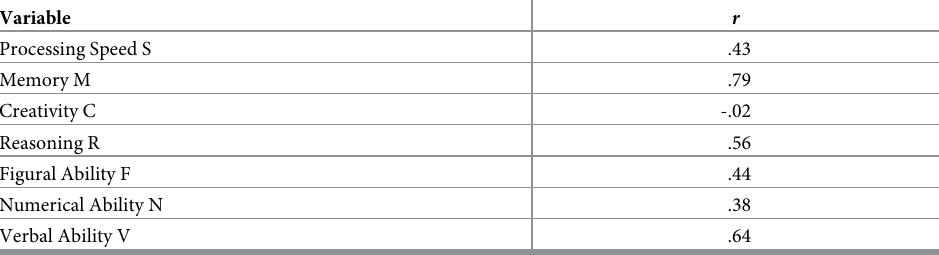
Table 4. Structure coefficients of the discriminant function 1 in Analysis